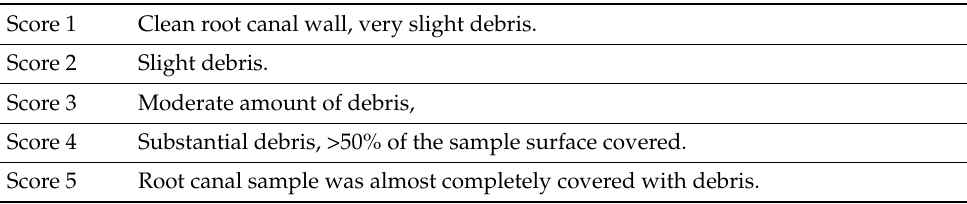
Table 1. Hülsmann criteria for debris scoring.